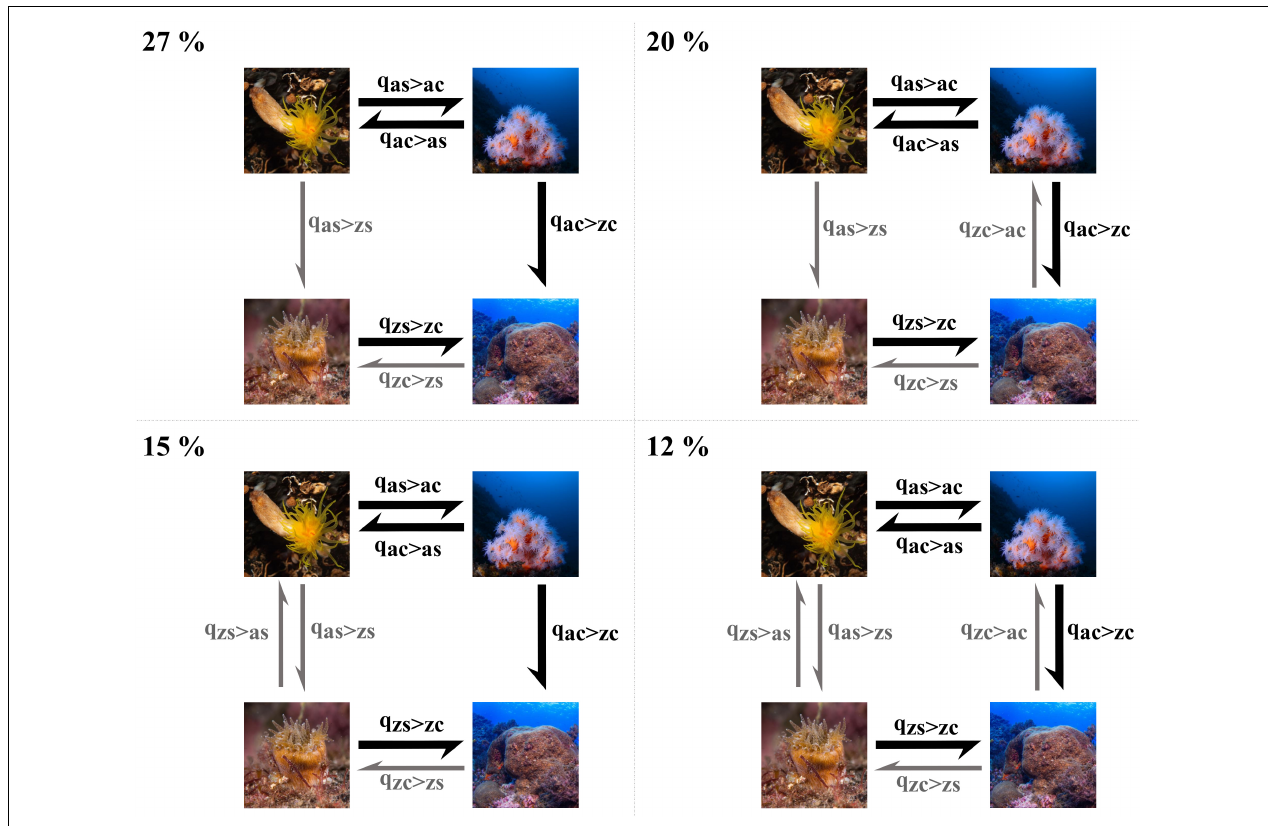
FIGURE 2 | Most frequent transition models in the posterior of the Discrete Dependent Covarion model. RJ-MCMC analyses were run over a sample of 500 trees with 1,000 samples per tree. The four states represented in pictures are: azooxanthellate/solitary (“as”), azooxanthellate/colonial (“ac”), zooxanthellate/solitary (“zs”), and azooxanthellate/colonial (“ac”). Arrows represent non-zero transition rates between states. Colors in arrows identify equal rates, with those in gray smaller than those in black. The four models sum 73% of the sample, while other models not represented appear in less than 5% of the sample. Photographs are courtesy of Luis Sánchez